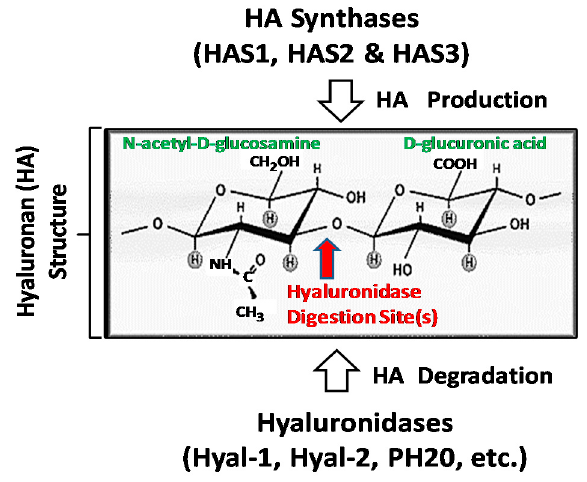
Figure 1. Hyaluronan (HA) structure regulated by HA synthases and